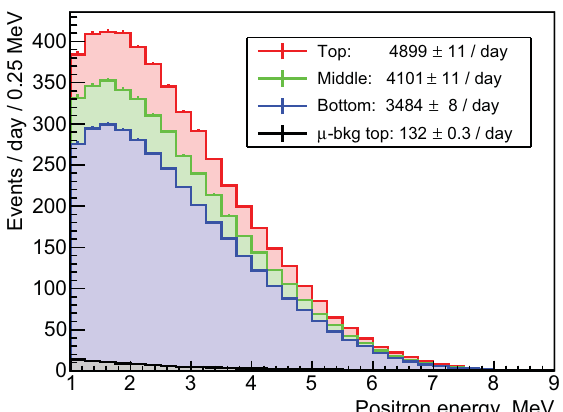
Figure 7. Positron energy distributions measured at different detector positions after subtraction of all backgrounds (statistical errors only). The background from neutrons produced by cosmic muons is shown for the top detector position.